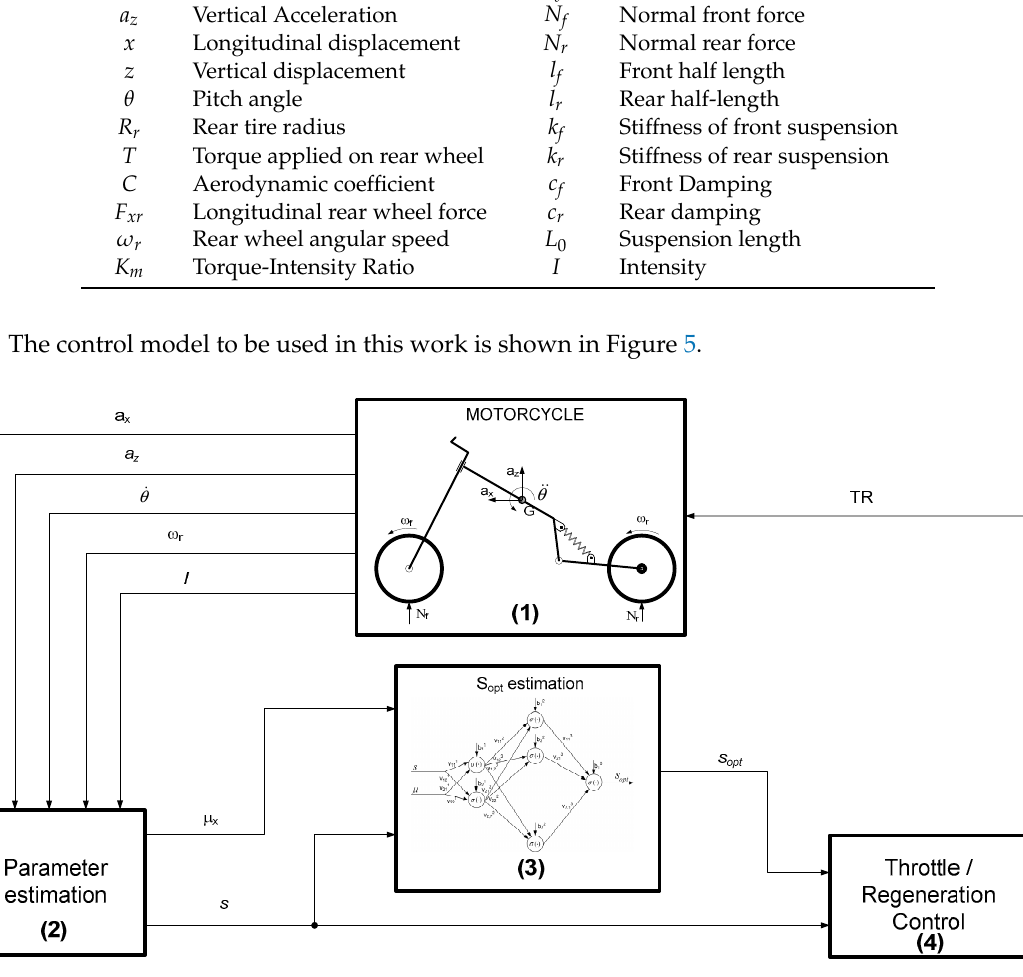
Figure 5. Motorcycle regenerative control scheme.